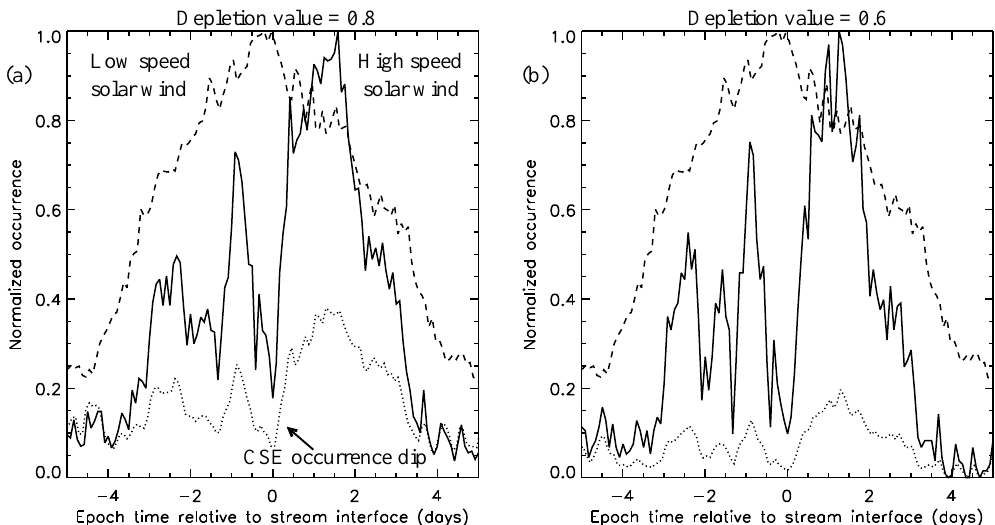
Fig. 7. Superposed epoch analysis of the occurrence of counter-streaming suprathermal electrons (CSE; solid line) and of all data (dashed line), relative to the time of the closest stream interface from Table 2, and normalized to the peak value. Epoch zero thus corresponds to the times of SI crossing, with negative (positive) epoch times being the preceding slow solar wind (following high speed wind). A two-hour interval binning has been used. The dotted lines show the CSE occurrence normalized to that of all data (i.e., solid curve normalized to dashed curve). (a) Results for a depletion value of 0.8. (b) Results for a depletion value of 0.6. The CSE occurrence in panel (a) varies between ∼ 10 and 270 counts (per 2-h bin), giving a high statistical significance to the trends. Occurrences are about twice to three times smaller in panel (b) (cf. Table 1), which is still significant. See text for further